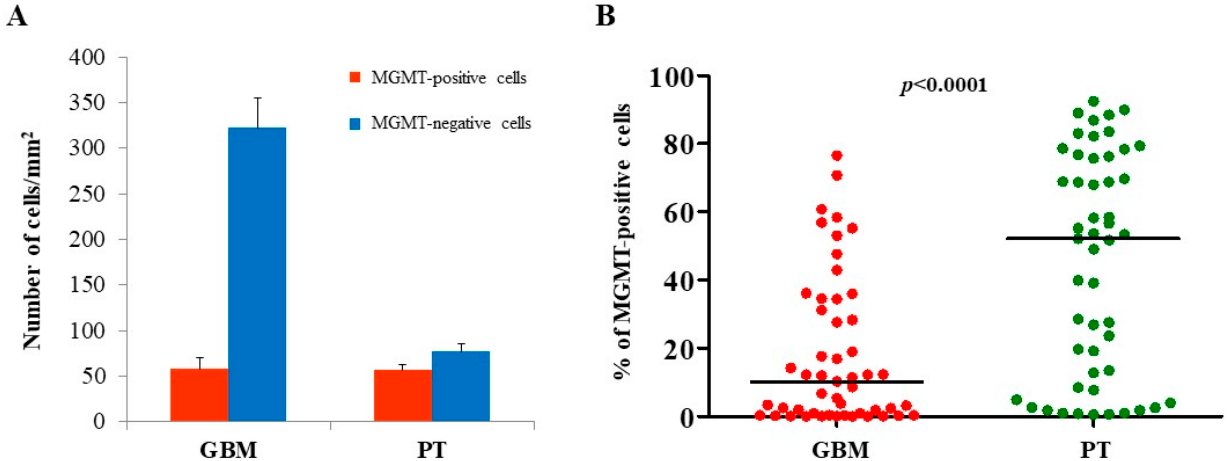
Figure 2. Stereological analysis of MGMT expression in both GBM and PT areas. Histological samples subjected to immunohistochemistry analysis were further evaluated by stereological analysis. The number of both labeled and unlabeled cells was employed to quantify the expression of MGMT in both GBM and PT tissue, as specified in the Materials and Methods section. ( A ) Red and blue bars show the number of MGMT-positive and MGMT-negative cells/mm 2 , respectively. The data are presented as the mean ± standard error (SE). ( B ) Plots show the percentage of MGMT-positive cells in GBM and PT areas. N = 50; the horizontal line represents the median value; p indicates the result of the Mann-Whitney test.